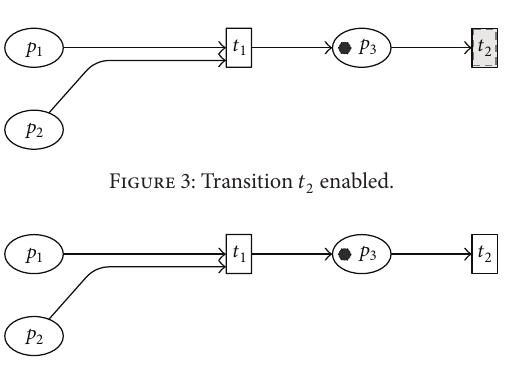
Figure 4: The model in